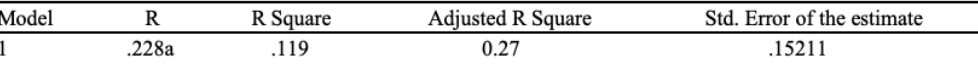
Table 1: Model summary